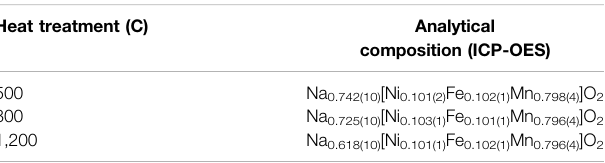
TABLE 1 | Analytical compositions after different heat treatments of NNFM. The obtained atomic ratios were normalized to one central cation per formula unit (Ni + Fe + Mn (cid:2) 1).